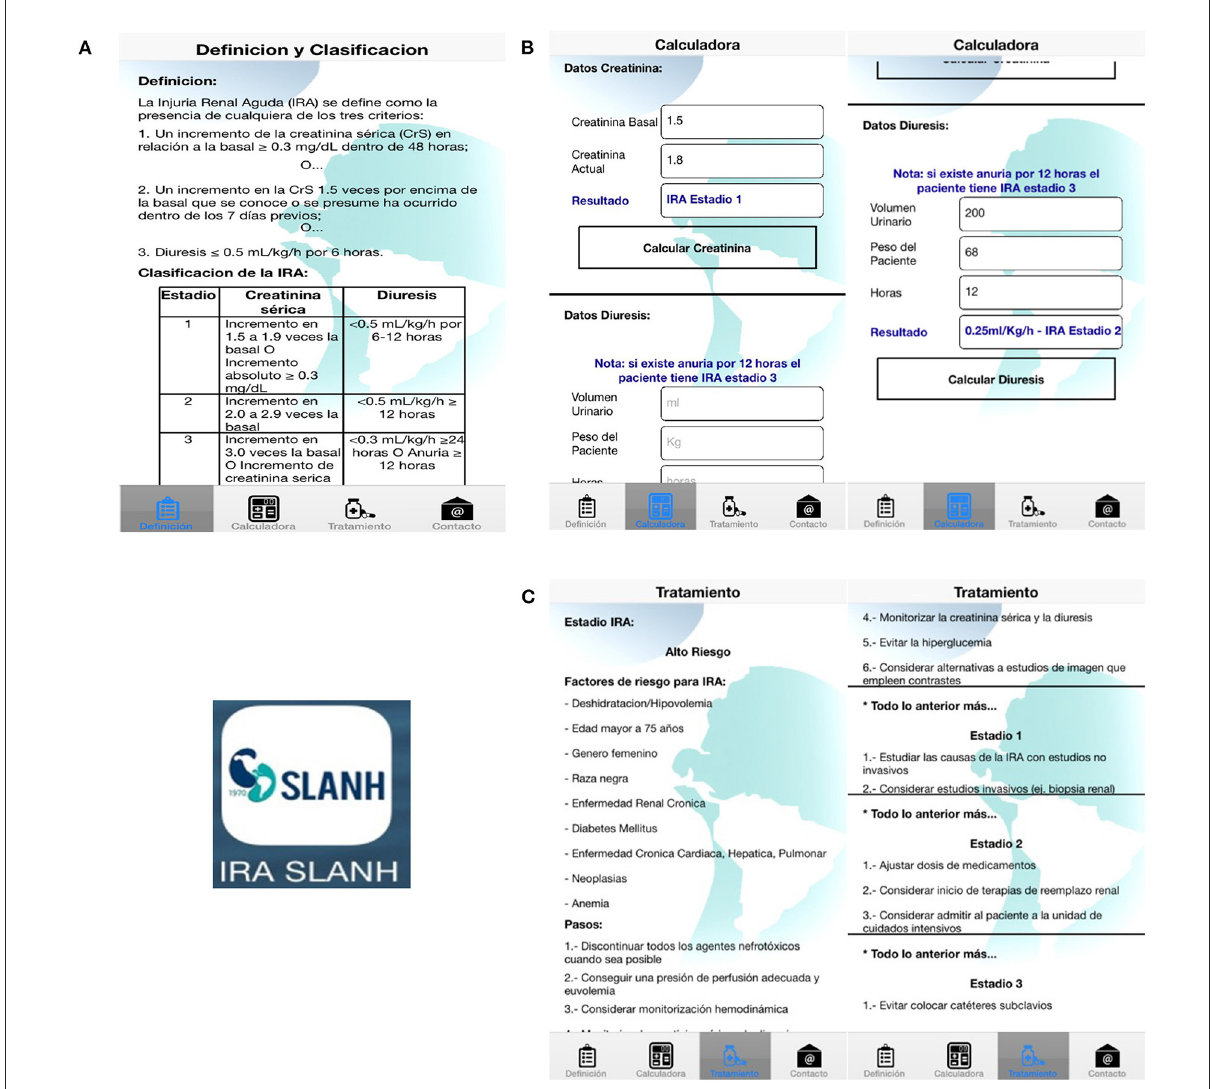
FIGURE1 Different tabs of the IRA SLANH application. (A) The first tab reviews the KDIGO criteria for the definition and stages of AKI (11). (B) The second tab calculates the presence and stage of AKI according to these guidelines; it uses either the patient’s urine output or a comparison of their baseline sCr to current sCr. (C) The third tab provides recommendations for clinical management according both to the level of the AKI, also based on the current KDIGO guidelines